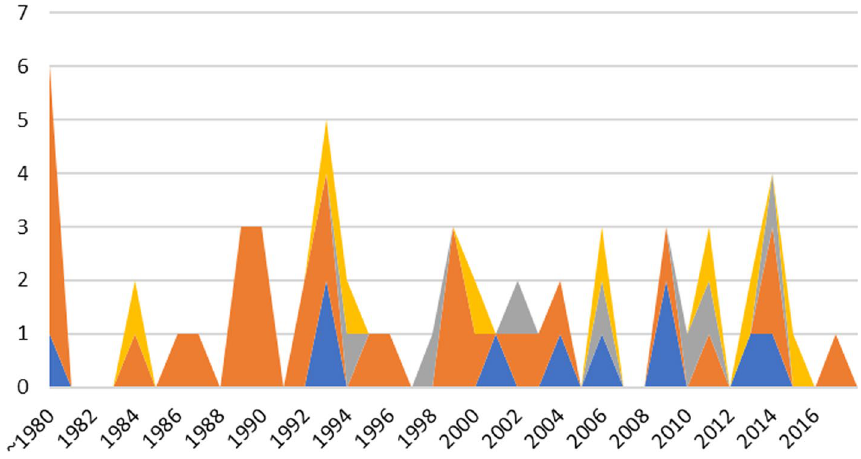
Fig. 2 Implementation of extraterritorial voting by regime type over time. Notes : Data from Wellman, Allen and Nyblade (Forthcoming)